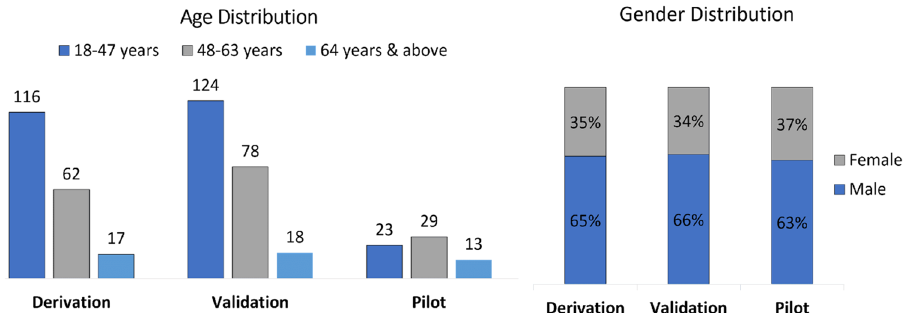
Figure 1. Data distribution in the derivation phase, validation phase and pilot